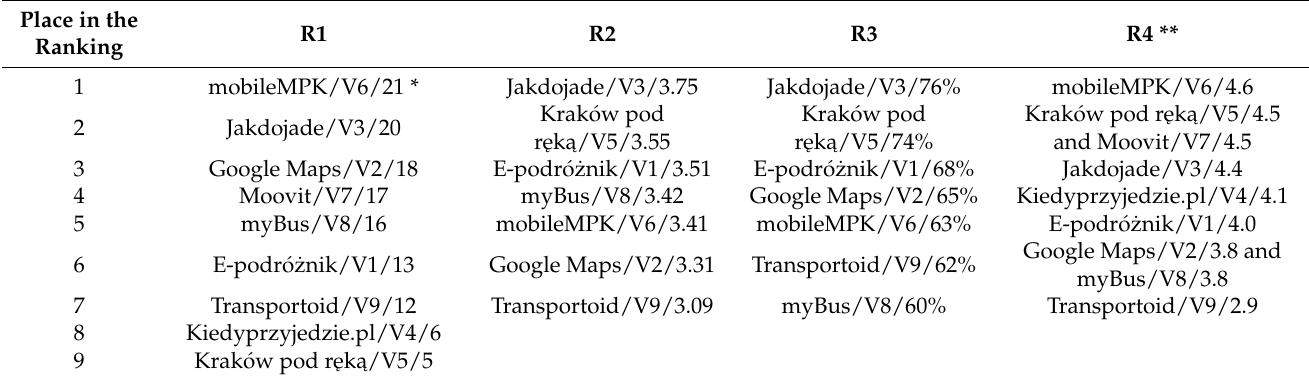
Table 7. Comparison of the final application rankings obtained using different